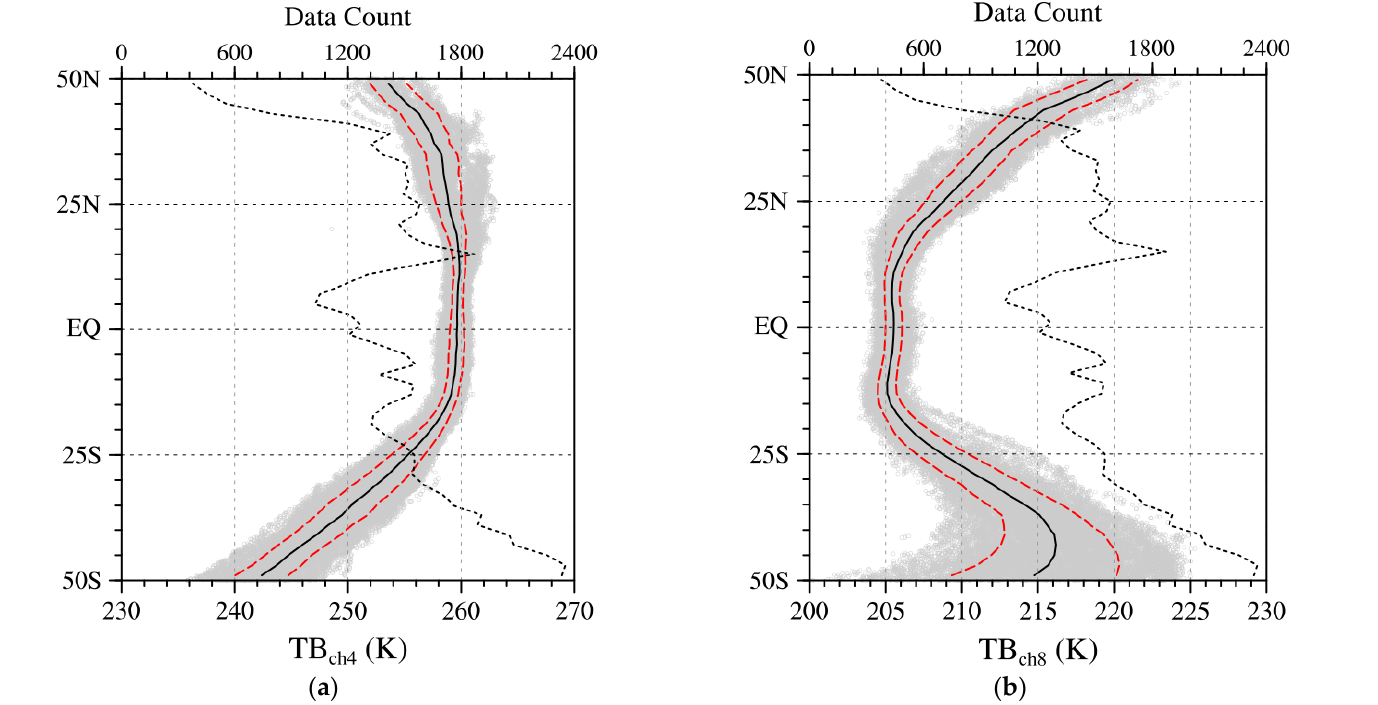
Figure 6. Scatterplots of latitudinal distributions of FY-3D MWTS-2 brightness temperature observations of ( a ) channel 4 and ( b ) channel 8 for all clear-sky nadir points over the ocean during the time from 10 to 31 July 2019 (gray dots). Also shown are the mean values (black curve) and mean ± one-standard deviation (red dashed curves) and data counts (black dotted curves) calculated at 2° latitudinal intervals.